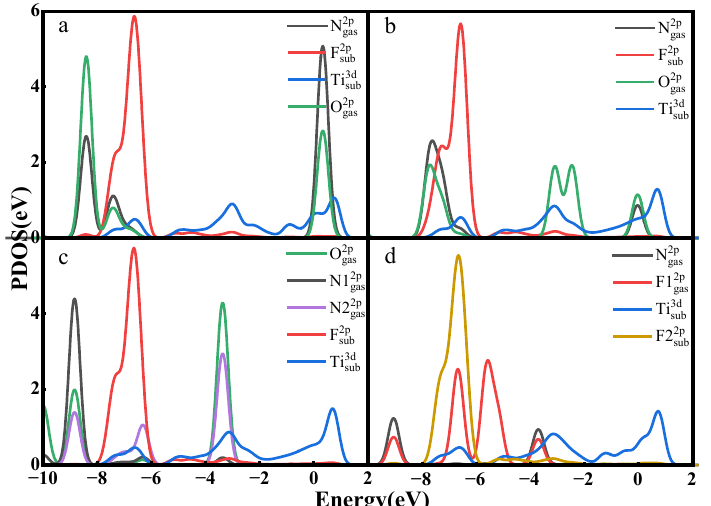
Figure 4. Partial electron density of states of Ti 3 C 2 F 2 adsorbing ( a ) NO, ( b ) NO 2 , ( c ) N 2 O, ( d ) NF 3.